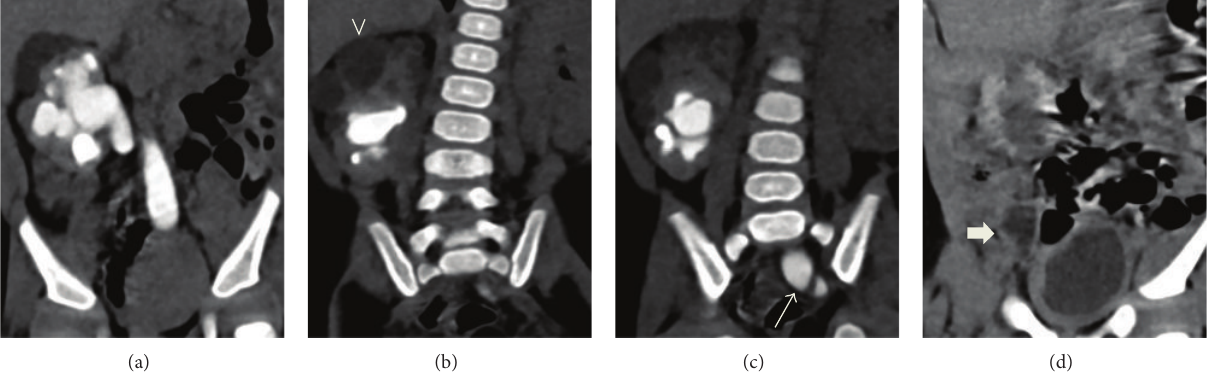
Figure 3: Contrast-enhanced abdomen CT, 6 months of age. (a) moderate hydronephrosis in the left crossed fused renal ectopic kidney; (b) noncommunicating cysts representing the orthotopic right multicystic dysplastic kidney in the superior aspect (arrowhead); (c) dilated tortuous left ureter at the left ureterovesical junction (arrow); (d) nonopacified right distal atretic ureter is not opacified (block arrow) confirming the absence of communication with the nonfunctioning orthotopic right multicystic dysplastic kidney.